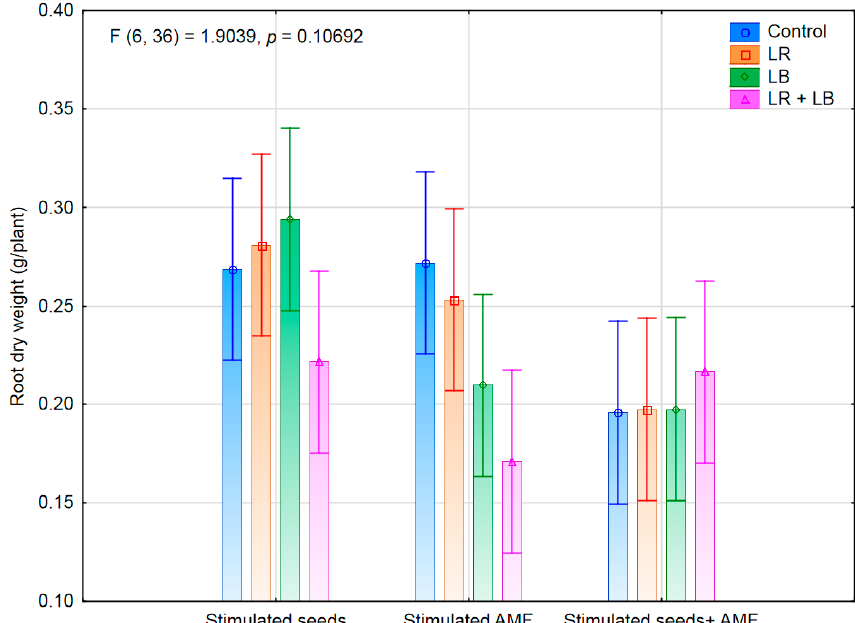
Figure 3. Effect of the interactions of the factors on the root weight.